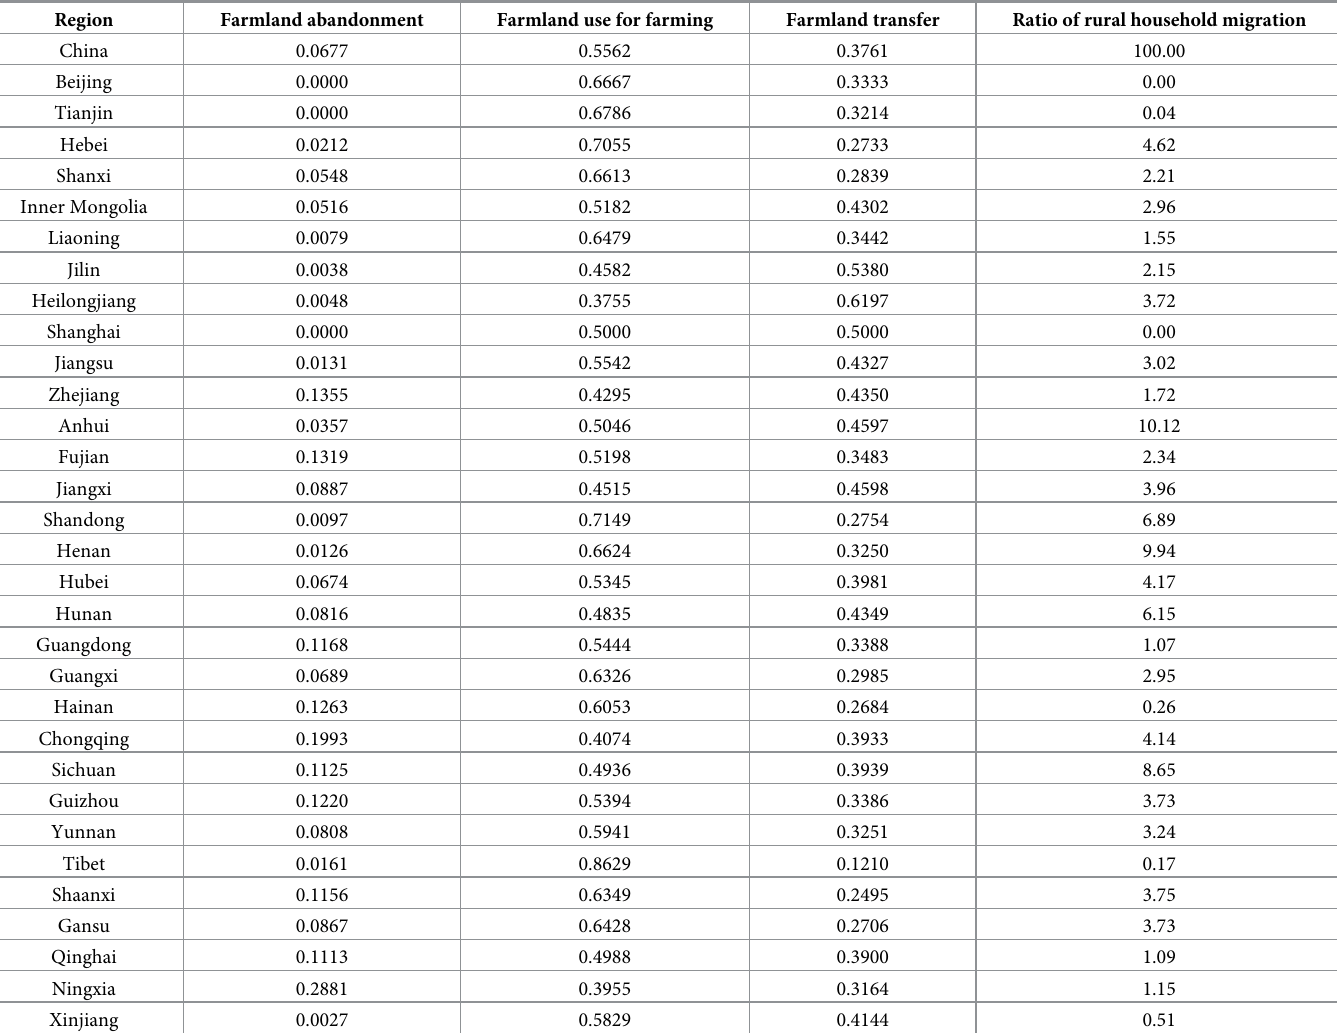
Table 1. Farmland use arrangements and migration in